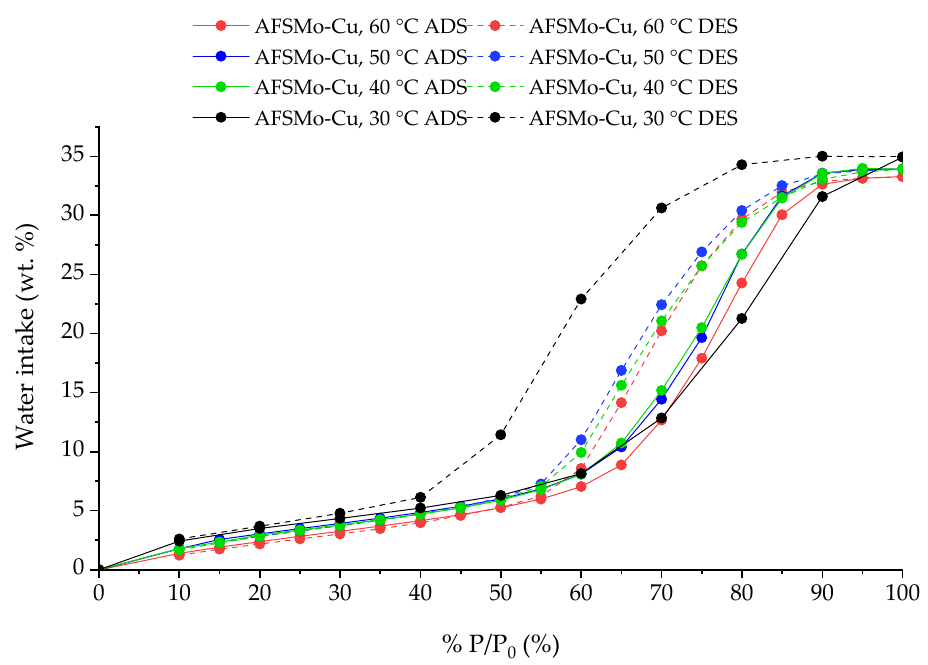
Figure 6. Adsorption and desorption isotherms for the AFSMo-Cu sample, at 30, 40, 50, and 60 ◦ C.